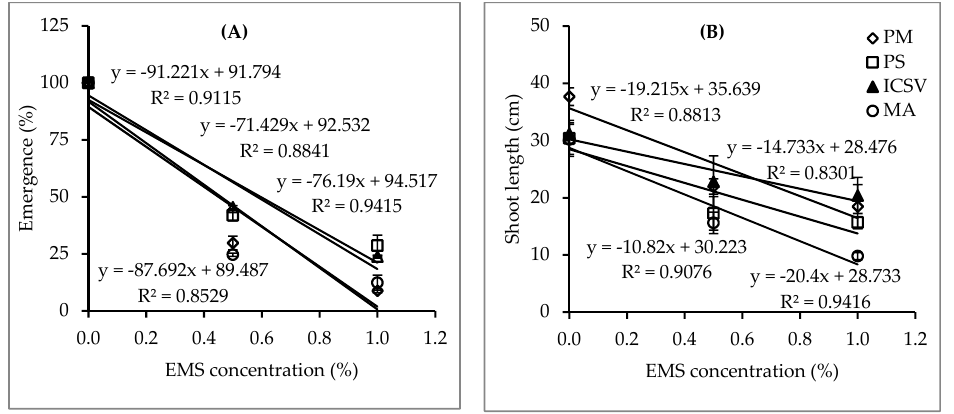
Figure 2. Emergence percentage ( A ) and shoot length ( B ) and fitted straight lines of four sorghum genotypes treated with three EMS concentrations in experiment I (bars represent standard error). Note: PM = Parbhani Moti, PS = Parbhani Shakti, ICSV = ICSV 15013 and MA =